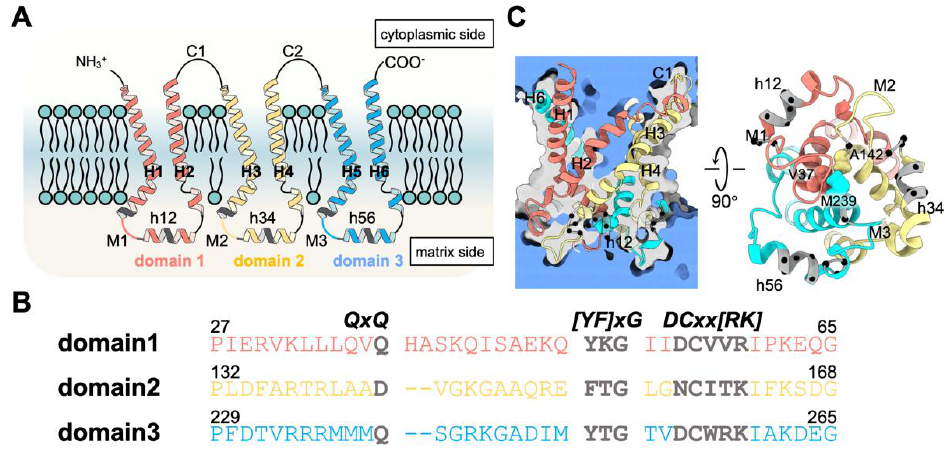
Figure 1. The matrix loops in AAC and conserved MCF motifs nearby. ( A ) Schematic diagram of the tripartite structure of AAC. Each domain is shown in a different color (domain 1 — salmon; domain 2 — yellow; domain 3 — cyan). The [YF]xG and DCxx[RK] motifs and triplet 38 (Q38, D143 and Q240) within the Px[DE]xx[KR]xRxQxQ motif are highlighted in gray. ( B ) Sequence alignment of the three domains from triplet 27 (conserved kink prolines) to triplet 65 (the G of the [DE]G motif at the C-end of short matrix helices h12, h34 and h56), with residues numbered based on bovine AAC1. The motif residues mentioned above are highlighted in gray characters. ( C ) The tertiary structure of AAC in the c-state. The left panel represents a cross-section of AAC and solvent, with the interior of AAC shown in gray and the solvent shown in blue. Cα atoms of the motifs mentioned above are highlighted by small black balls, and residues in the hydrophobic plug (V37, A142 and M239) at the C-end of odd-numbered helices are shown as spheres.